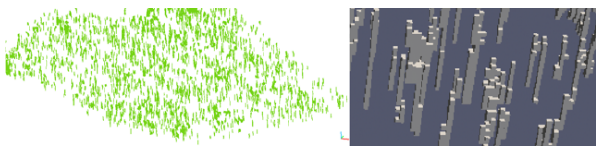
Figure 14: Extracted trunks (left) and detail showing voxels